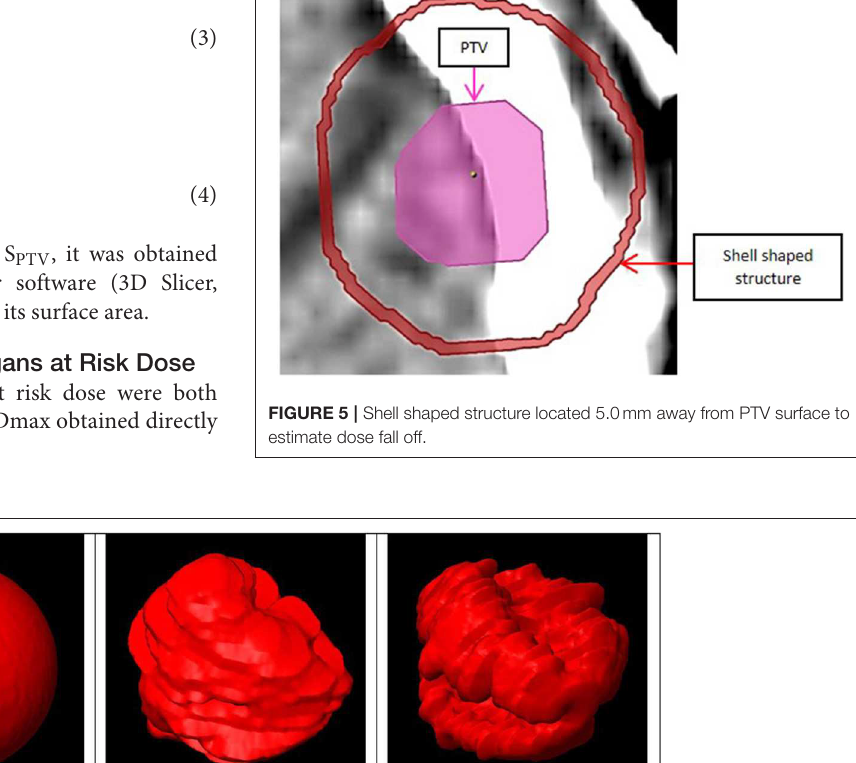
Frontiers in Oncology |